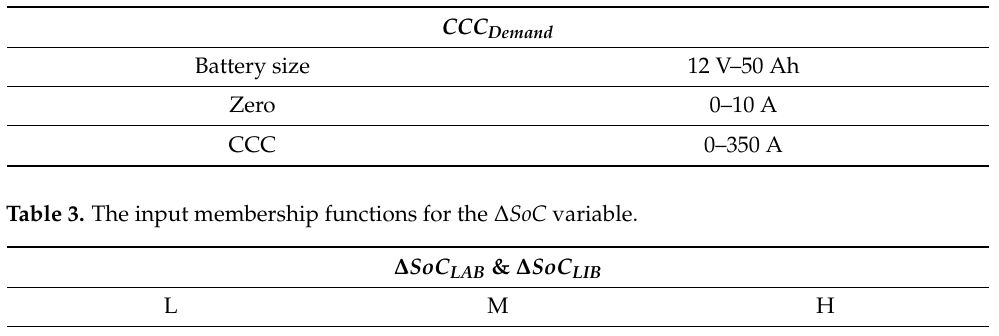
Table 2. The input membership function for the required cold cranking current variables.